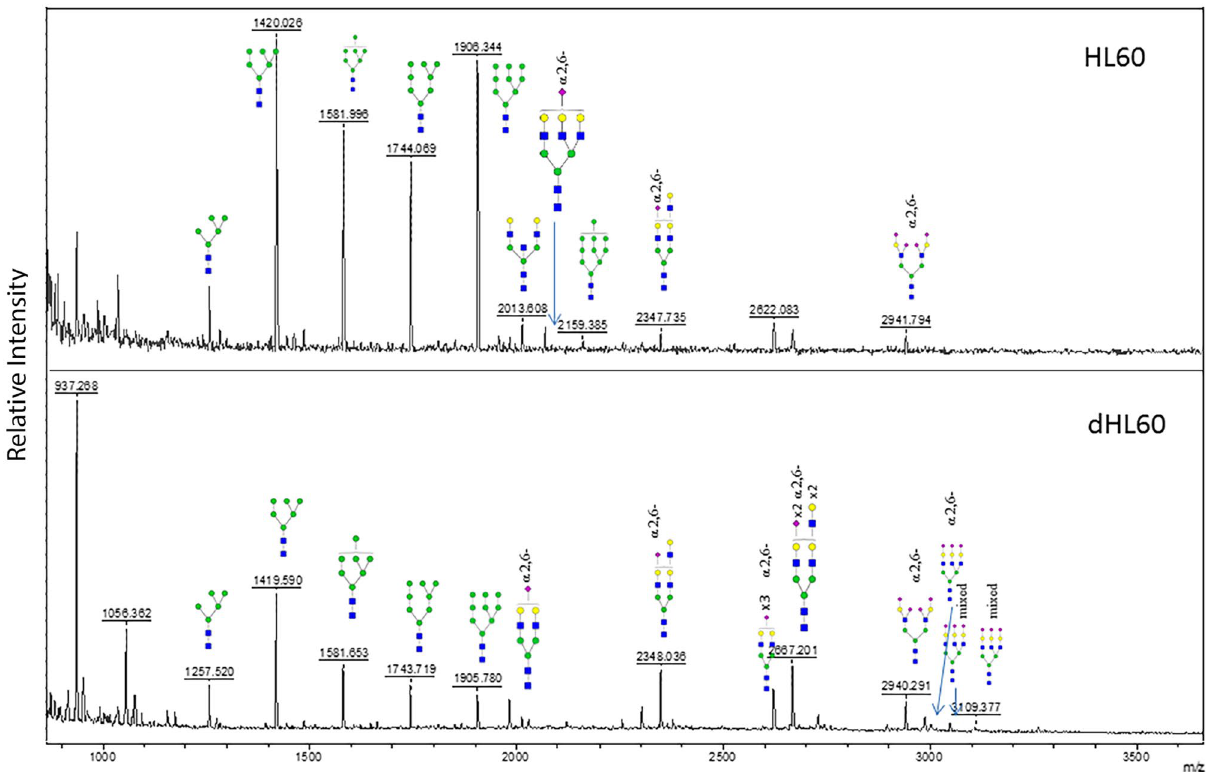
Figure 8. MALDI ToF MS of Sequentially Labeled α2,3- and α2,6-linked Sialyl N-glycans. N-glycans derived from HL60 (top panel) and dHL60 (bottom panel) cells were sequentially labeled by esterification and amidation of α2,3- and α2,6-linked SA, respectively. The α2,6-linked SA substituted N-glycans were dramatically increased in dHL60 cells. Cartoonized structures shown with the α2,6- label denote exclusive substitution with α2,6-linked SA whereas those denoted as mixed contain both α2,3- and α2,6-linked SA substitutions. Symbols represent the following monosaccharides: Blue square, GlcNAc; Green circle, Man; Yellow circle, Gal; Pink diamond, NeuAc. These data are representative of 2 independent